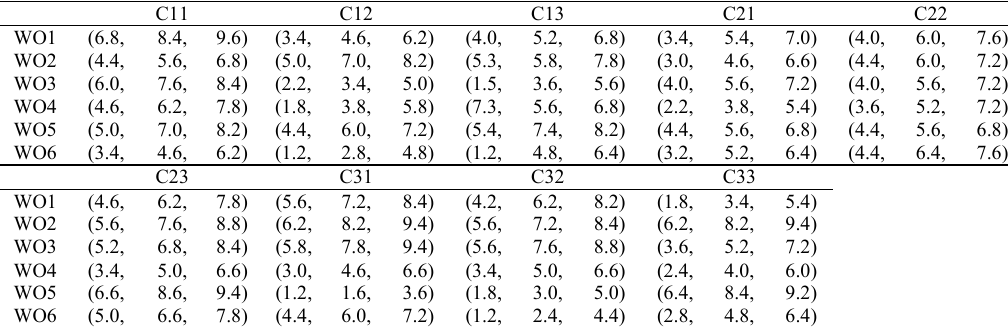
Table 7: Aggregated fuzzy decision matrix